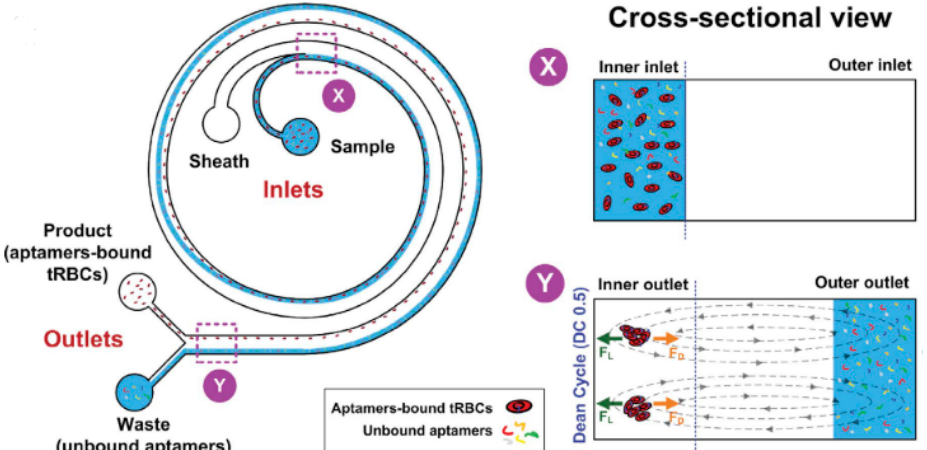
Figure 4. Results from inertial separation of unbound aptamers. Due to the dean drag forces, the unbound aptamers migrate towards the outer wall and into the water outlet. Bound aptamers and microfluidic beads experience a lift force which keeps them close to the inner wall. Reprinted with permission from ref. [51] © 2015 Scientific Reports.